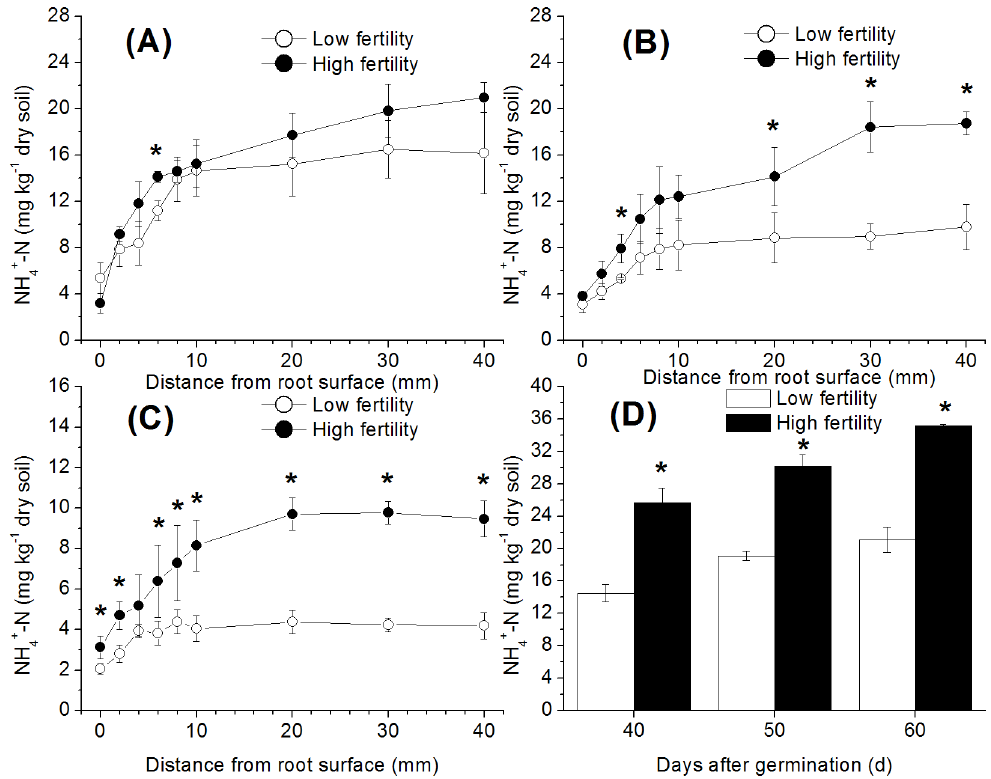
Figure 3. NH 4 + -N measured at various distances from the rice root surface in paddy soils with different fertility levels (A) 40 d after germination, (B) 50 d after germination, and (C) 60 d after germination, relative to the (D) control (without rice plants). The bars indicate 6 SD. Dots and bars with * indicate a significant difference (p , 0.05) between the two fertility levels.